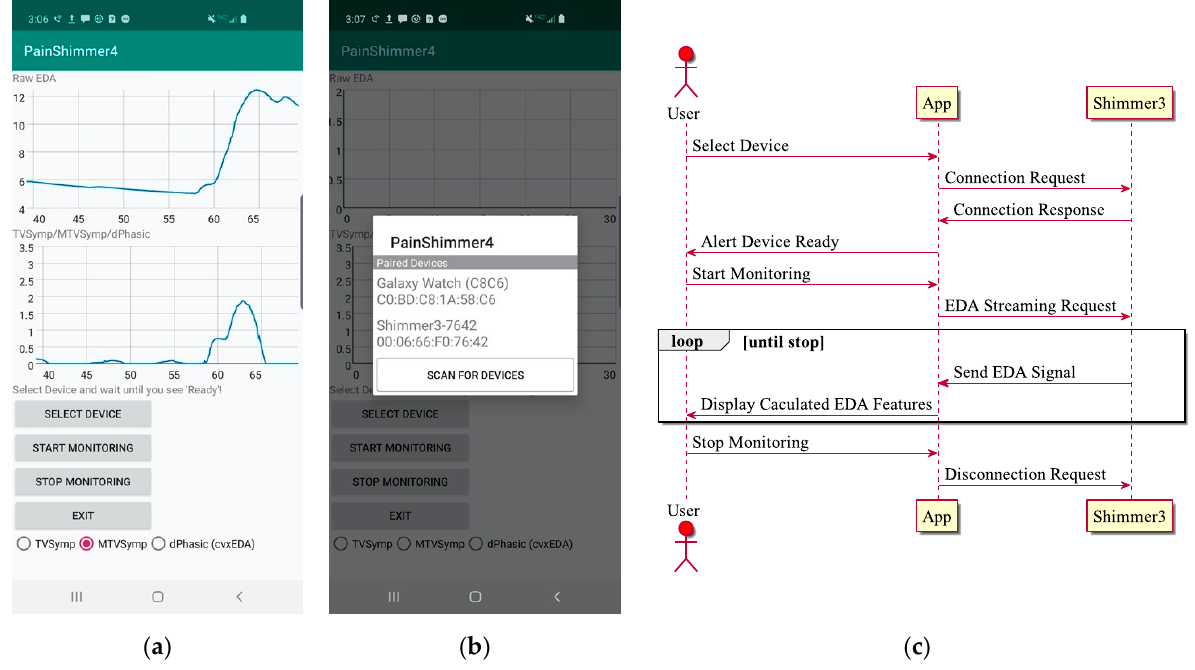
Figure 2. ( a ) Main screen (heat pain was induced around 56 s), ( b ) device selection in the smartphone application, and ( c ) the unified model language (UML) sequence diagram for the application.